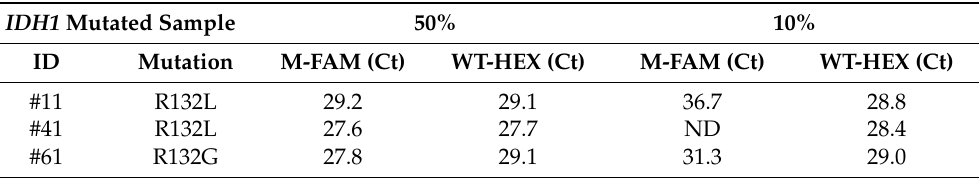
Table 3. Mean Ct obtained with IDH1 R132L and R132G mutated formalin-fixed paraffin-embedded (FFPE) samples pooled with IDH1 WT